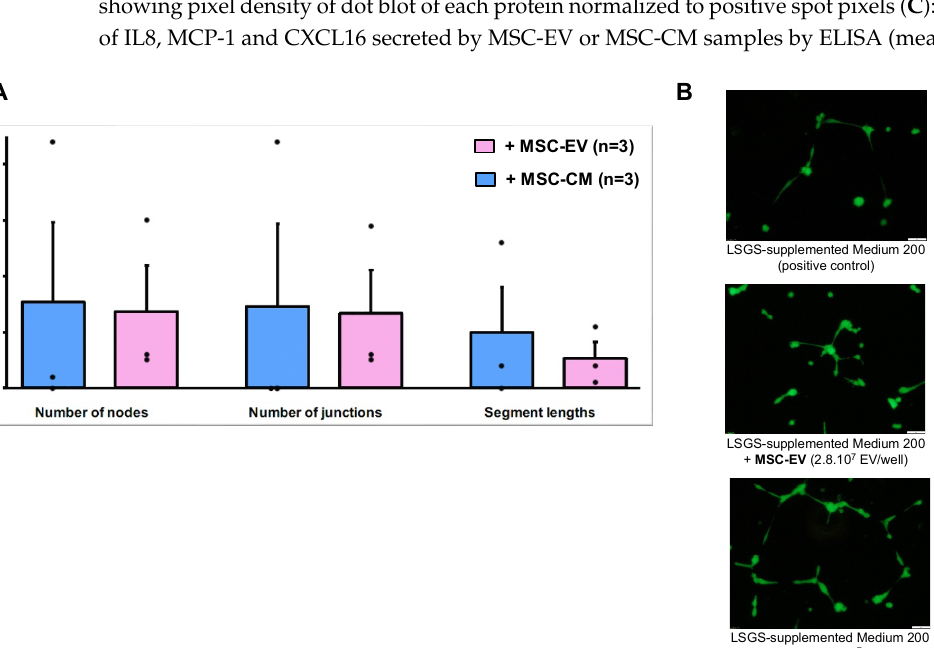
Figure 10. Tube formation of HUVECs incubated with MSC-CM or MSC-EV. ( A ) Number of nodes, number of junctions and number of segments length were quantified in different experimental conditions with the ImageJ software. The graph shows the percentage increase observed with medium + MSC-CM or + MSC-EV compared to the positive control. Values represent means ± SEM from three independent experiments. ( B ) Representative images (10× magnification, scale bar = 50 mm) of tube formation were taken using fluorescent microscopy (calcein-AM staining), 12 h after cell seeding.